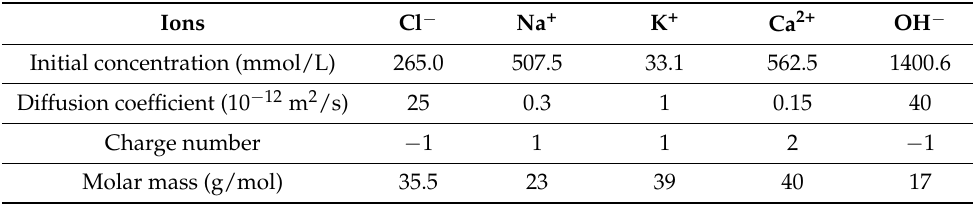
5 Figure 2. Schematic illustration of the finite difference method.